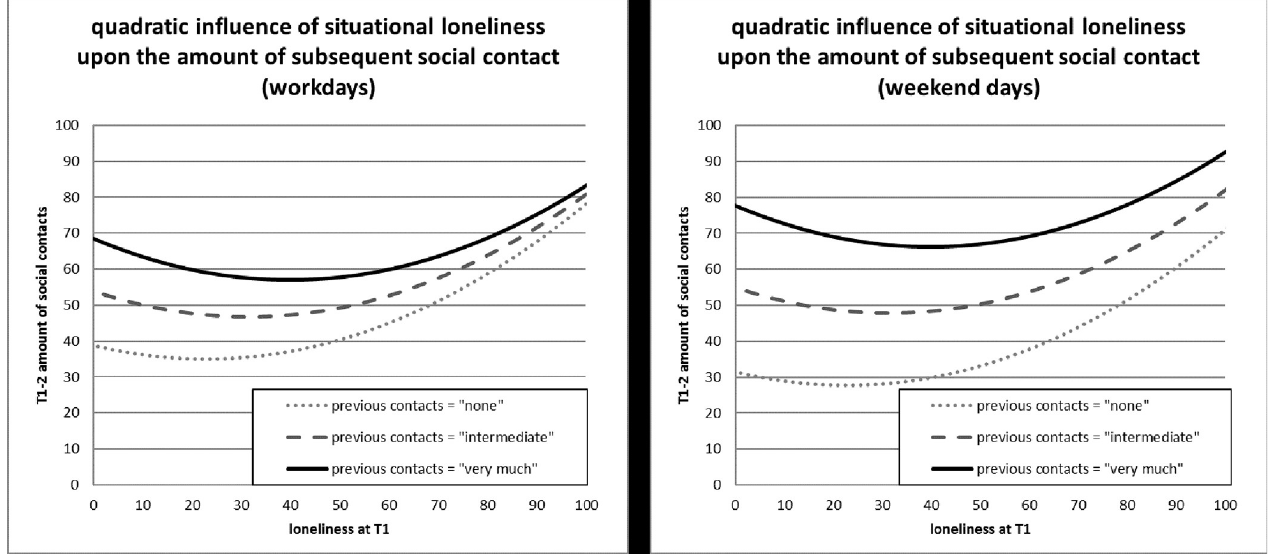
Fig 2. Quadratic influence of situational loneliness on subsequent social contacts, as conditioned by preceding social contacts.